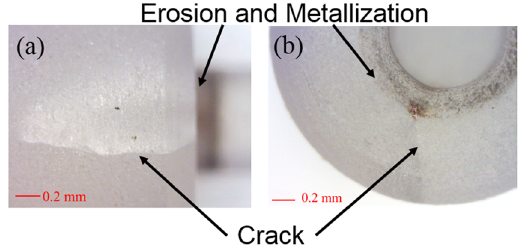
FIG. 29. (a) The side view, and (b) the top view of the images of the crack on the rolling-pin sapphire